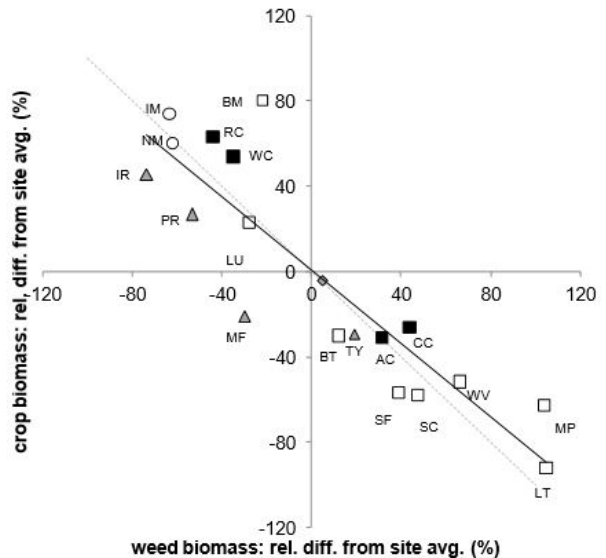
Figure 4. Relationship between weed biomass and crop biomass in early autumn 2009, both expressed as relative difference (in %) of species values from respective site av- erages. Filled squares: Clover species (Trifolium spec.); open squares: other legume species; grey triangles: grass species; open circles: All Species Mixtures (ASM); Grey di- amond: average of monocultures (only ASM components); Black line: linear regression through all points; broken line: y = –x. Mean of five sites (all except Barrington